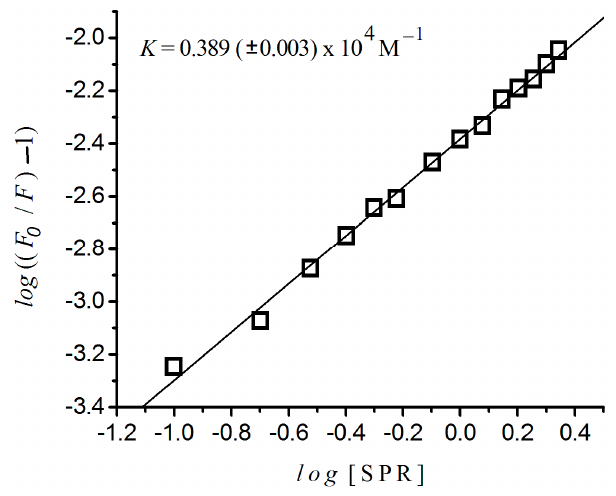
Figure 5. Variation of log(( F o /F) − 1) versus log((sulpiride)) for HSA at 37 °C. Excitation λ = 290 nm; (albumin) = 2 × 10 − 6 M; 10 − 3 M phosphate buffer, pH 7.4.